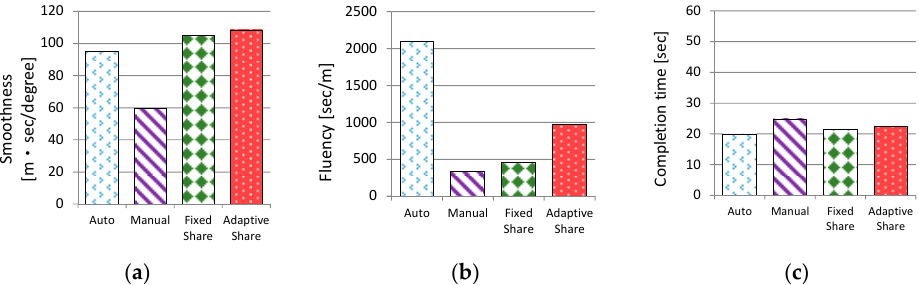
Figure 14. Experimental results of over-speeding operation using four control modes in terms of the three criteria. ( a ) Smoothness ( b ) Fluency, ( c ) Completion time.